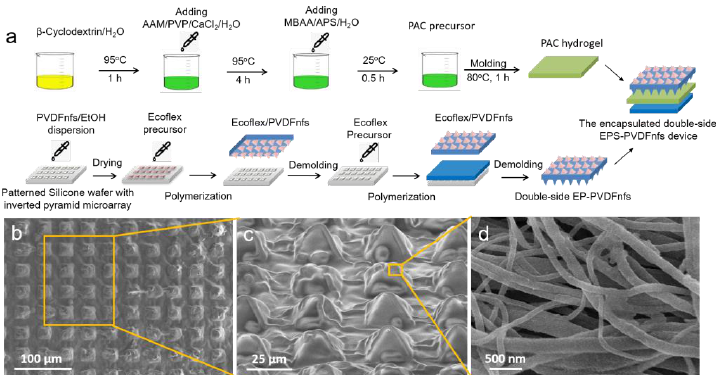
Figure 1. ( a ) Steps in the fabrication of the double-side EPS-PVDFnfs device. ( b – d ) Low- to high- resolution scanning electron microscopy images showing top-view and side-view with wrinkled micropyramid units and the surface PVDF nanofibers of the double-side EP-PVDFnfs thin film.